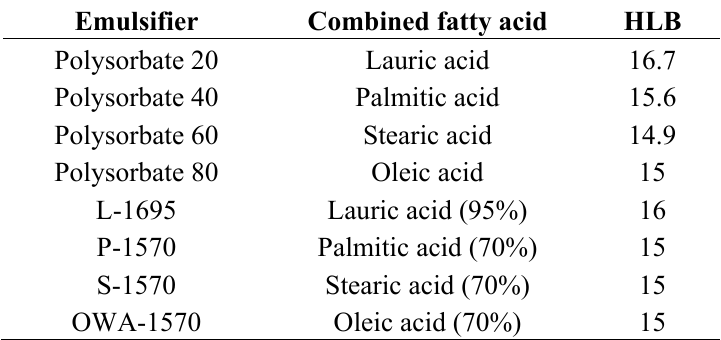
Table 1. The type of attached monoester fatty acids and HLB values of the emulsifiers